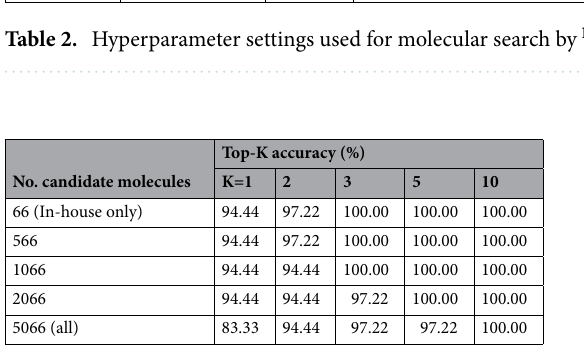
Table 3. Results of molecular search by 13 C NMR